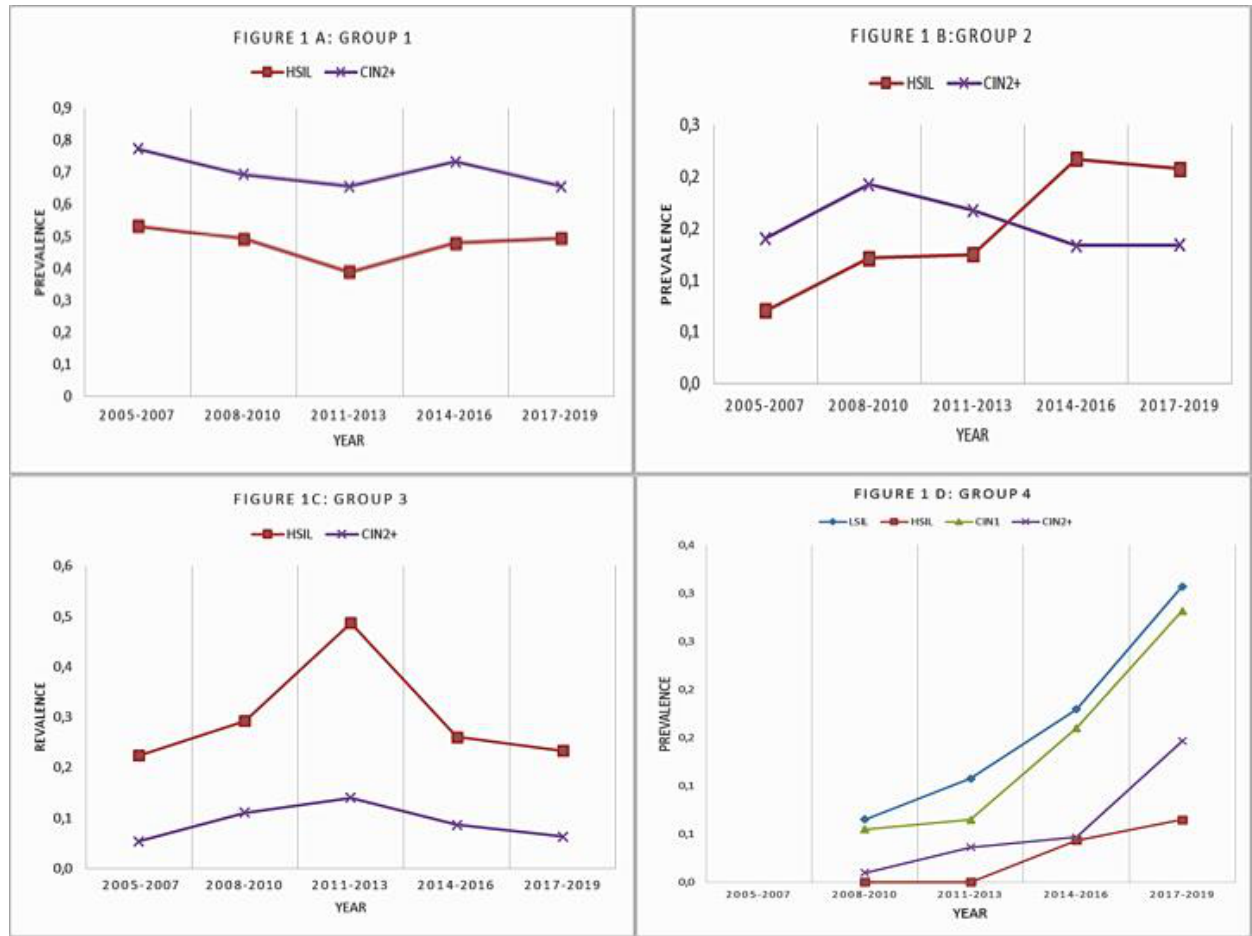
Figure 1. Association between cytological and histological findings and human papillomavirus (HPV) genotypes. ( A ) prevalence of the seven High risk-HPV related to nona-valent vaccine on cytology and histology. ( B ) prevalence of the other HR-HPVs not included in vaccine on cytology and histology. ( C ) prevalence of the low-risk HPV on cytology and histology. ( D ) prevalence of the negative/untypable HPV on cytology and histology.